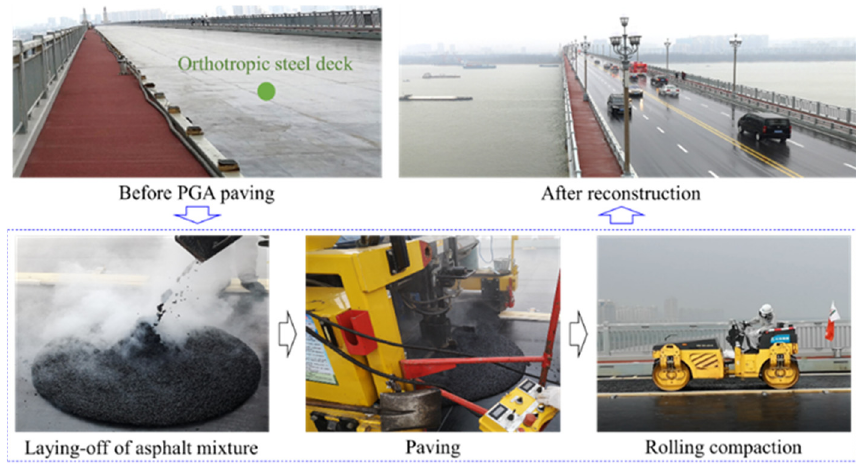
Figure 3. High-temperature pavement paving in the reconstruction of Nanjing Yangtze River Bridge (NYRB) (Images taken by Q.W.).